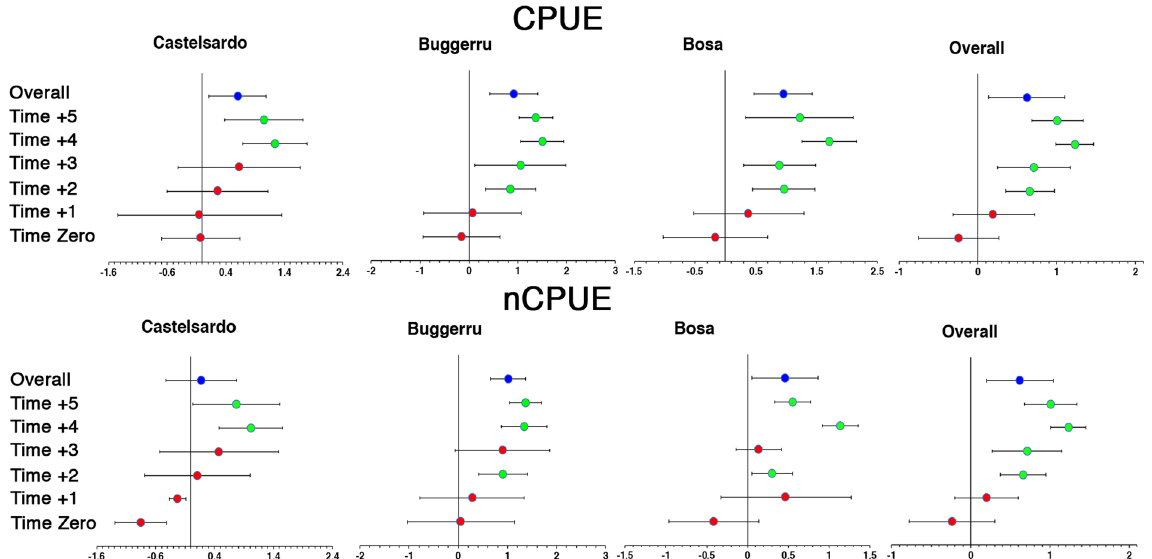
Figure 3. Forest Plot showing cumulative impacts of FPAs (ln–response ratio; mean ± 95% confidence intervals). Red circles: non-significant ratios; green circles: significant ratios; blue circles: overall ratio, across time. Cumulative effects are significant if confidence intervals do not overlap zero.